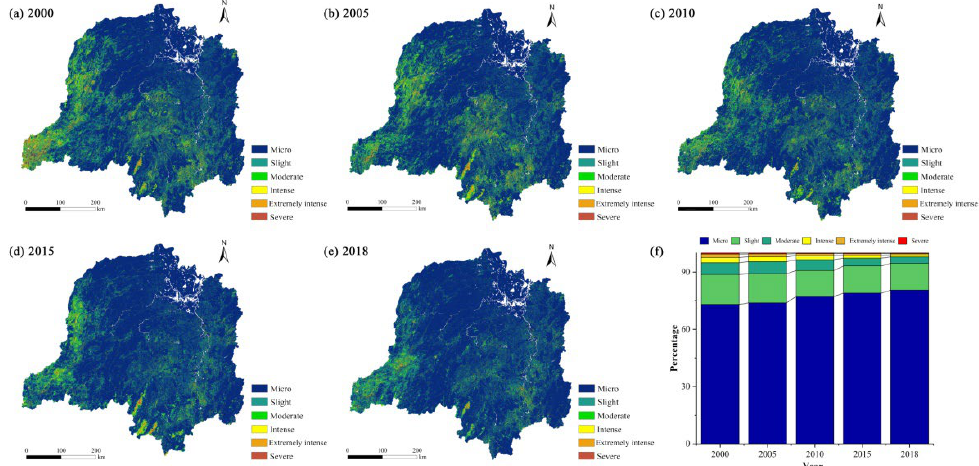
Figure 3. Spatial and temporal distribution of soil erosion in the Dongting Lake basin from 2000 to 2018: ( a – e ) soil erosion distribution, and ( f ) soil erosion class percentages.